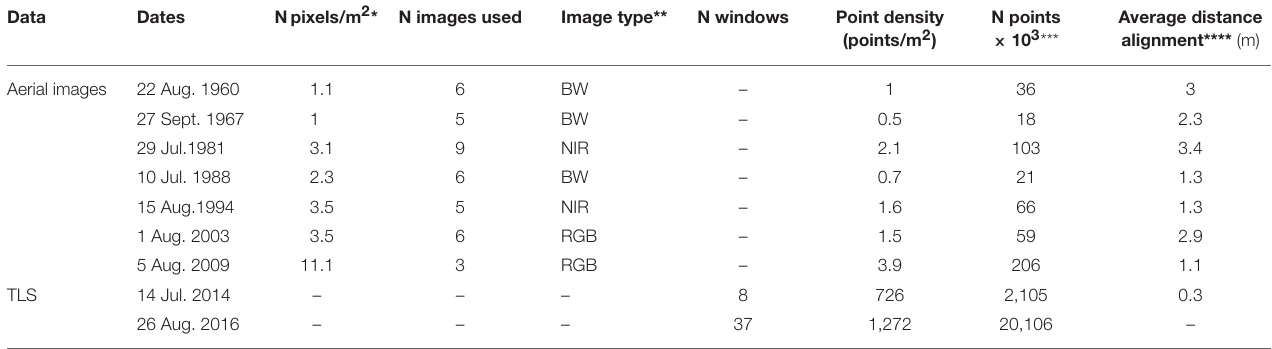
TABLE 1 | Data sets used to generate point clouds by SfM and TLS for the period 1960–2016.